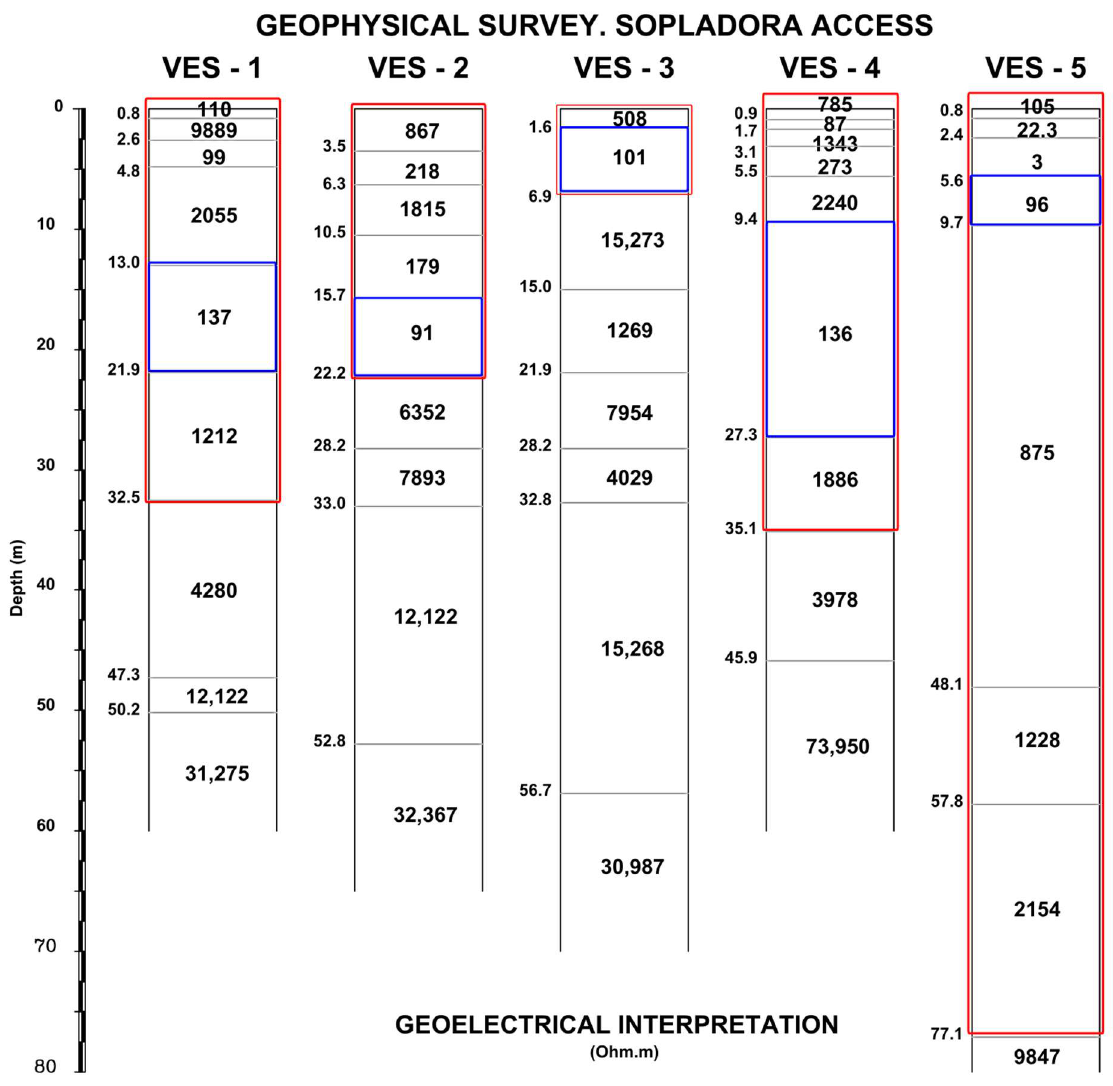
Figure 7. Results obtained in the interpretation of VES surveys (in Ohm.m). A red rectangle marks the defined sediment layers over the basement, and the blue rectangles show the water saturation levels.